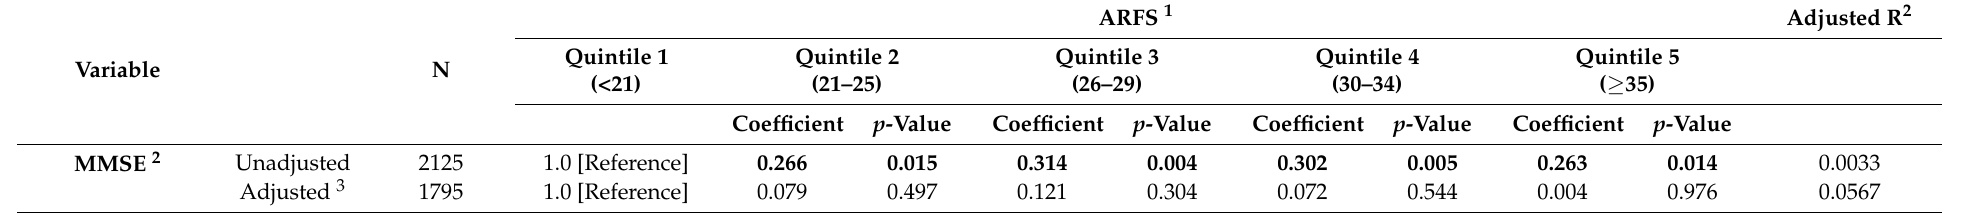
Table 2. Unadjusted and adjusted linear regression of MMSE score (n = 2125) by quintiles of ARFS score in the Hunter Community Study.